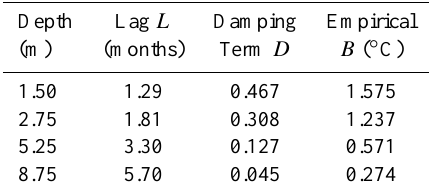
Table 3. Depth-dependent parameter values for the GST- groundwater temperature transfer function. Depth Lag L Damping